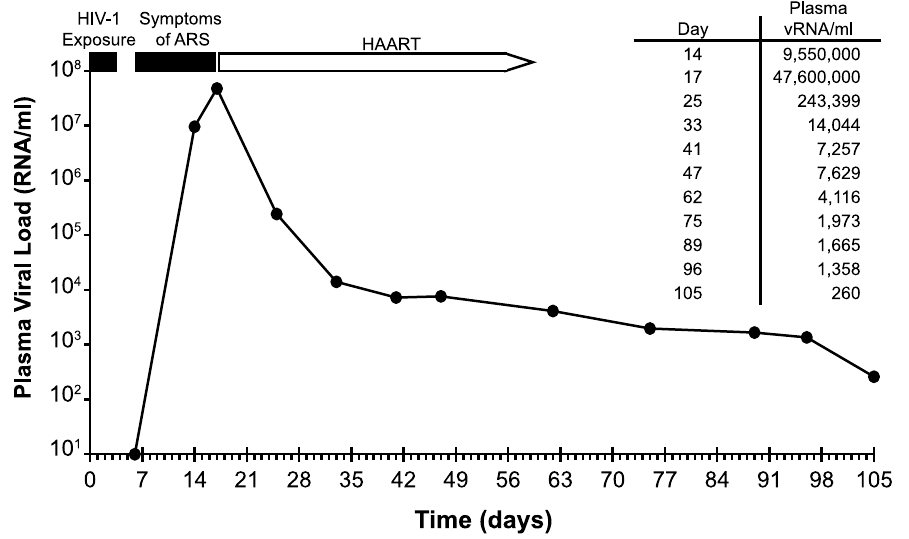
Figure 3. Time course of HIV-1 exposure, symptom onset, viral kinetics, and initiation of antiretroviral therapy in subject AD17. ARS, acute retroviral syndrome. HAART, highly active antiretroviral therapy. For purposes of mathematical modeling, a plasma virus load of 10 RNA molecules per milliliter was estimated at day 6.